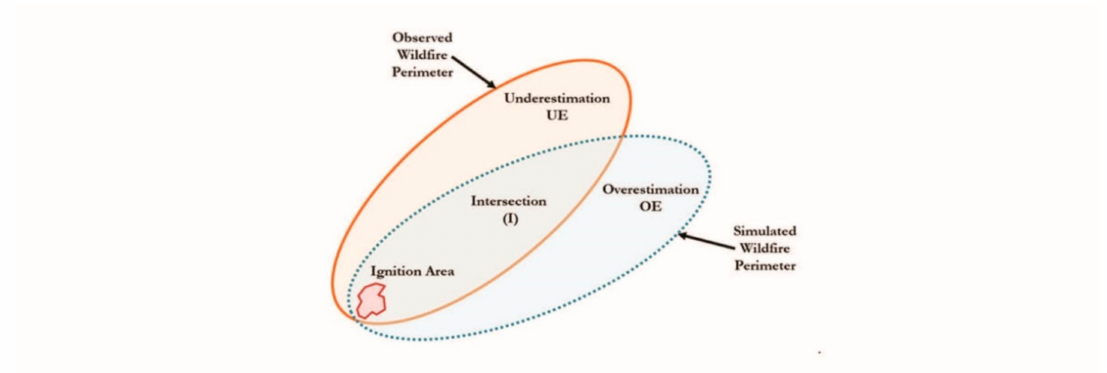
Figure 2. Graphical representation of the observed and simulated wildfire perimeters, as well as the three predictive areas, underprediction, intersection and overprediction, that are a product of each simulation, adapted from Du ff , Chong, and Tolhurst